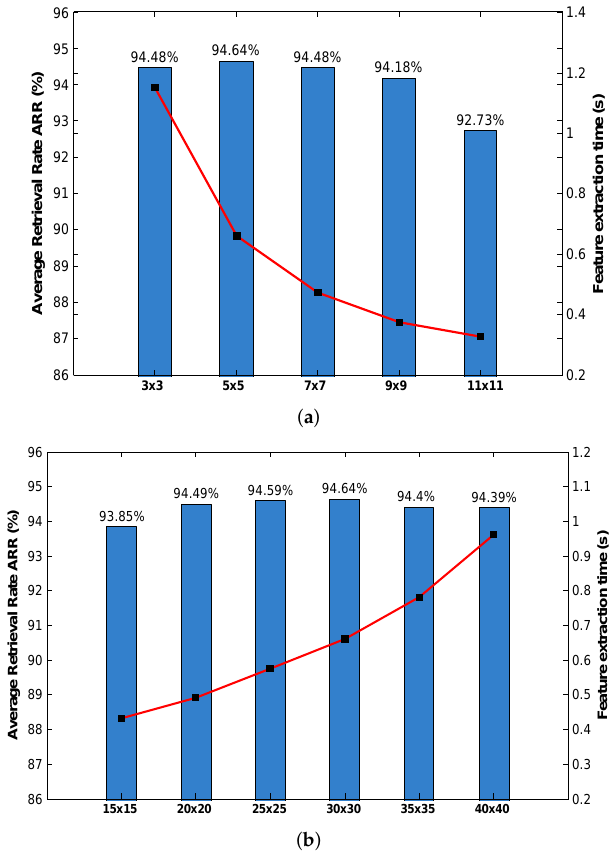
Figure 5. Sensitivity of the proposed method to its parameters in terms of average retrieval rate (%) and feature extraction time ( s ). Experiments were conducted on Vistex-640 data set using the 27D LED+RD. ( a ) sensitivity to window size ω 1 for keypoint extraction; ( b ) sensitivity to window size W for descriptor